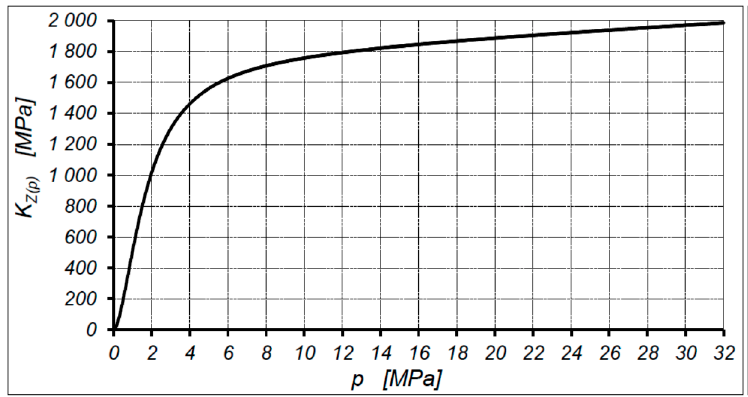
Figure 9. Tangential isentropic bulk modulus K Z(p) of Total Azolla mineral oil in the test stand